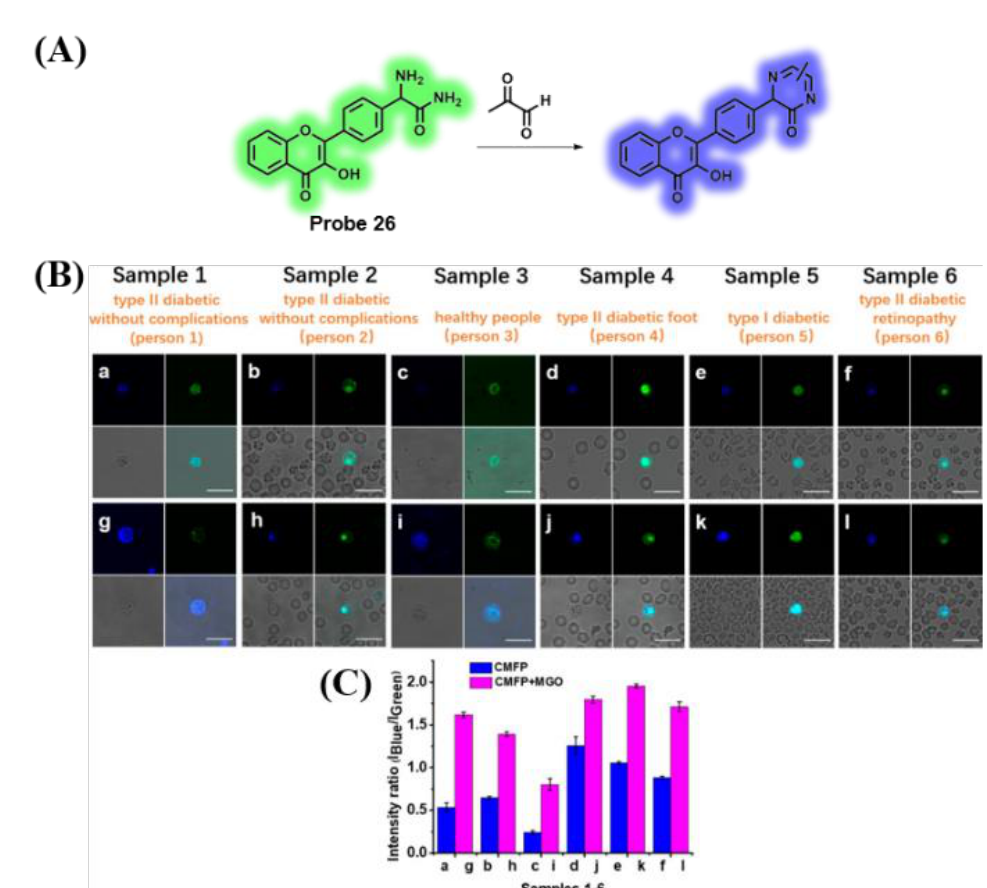
Figure 22. ( A ) Imaging mechanism of probe 26 ; ( B ) probe 26 application in leukocytes; ( B - a , B - g )